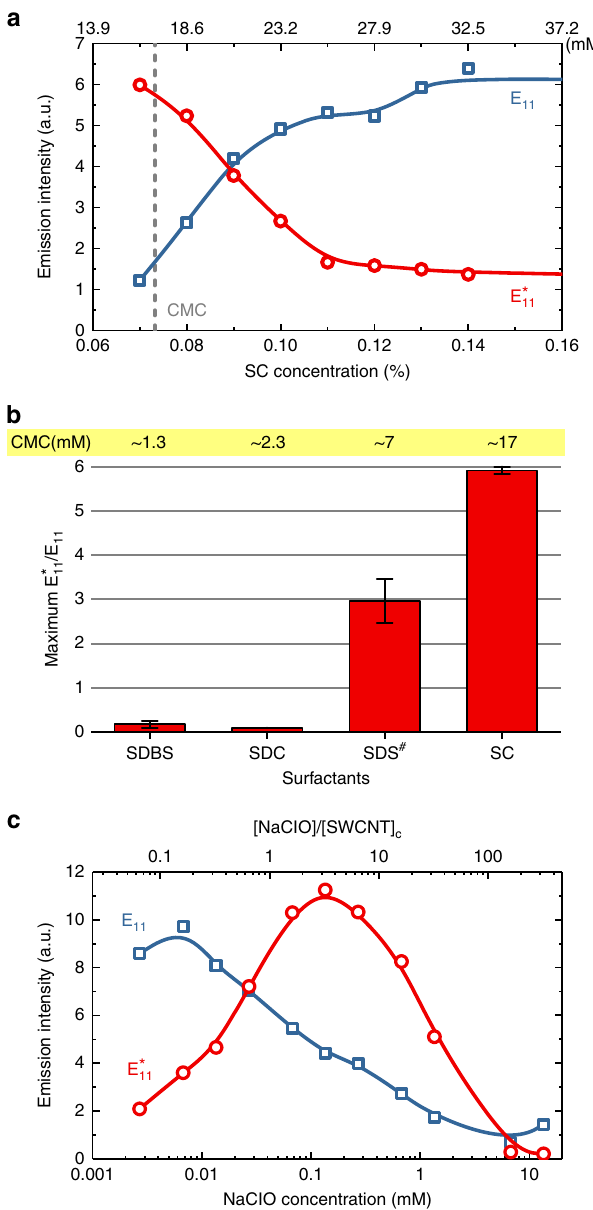
Fig. 3 Effects of surfactants and reactant on doping ef fi ciency. a E 11 and E (cid:1) 11 emission intensities after treatment of samples suspended in various SC concentrations. b Maximum ratio of E 11 – E (cid:1) emission intensities for 11 treated samples suspended in different surfactants. The hash symbol represents SWCNT fl uorescence quenched after addition of oxidizing agent. Error bars indicate s.d. from the spectral measurement noise. c NaClO concentration dependence of E 11 and E (cid:1) emission intensities after 11